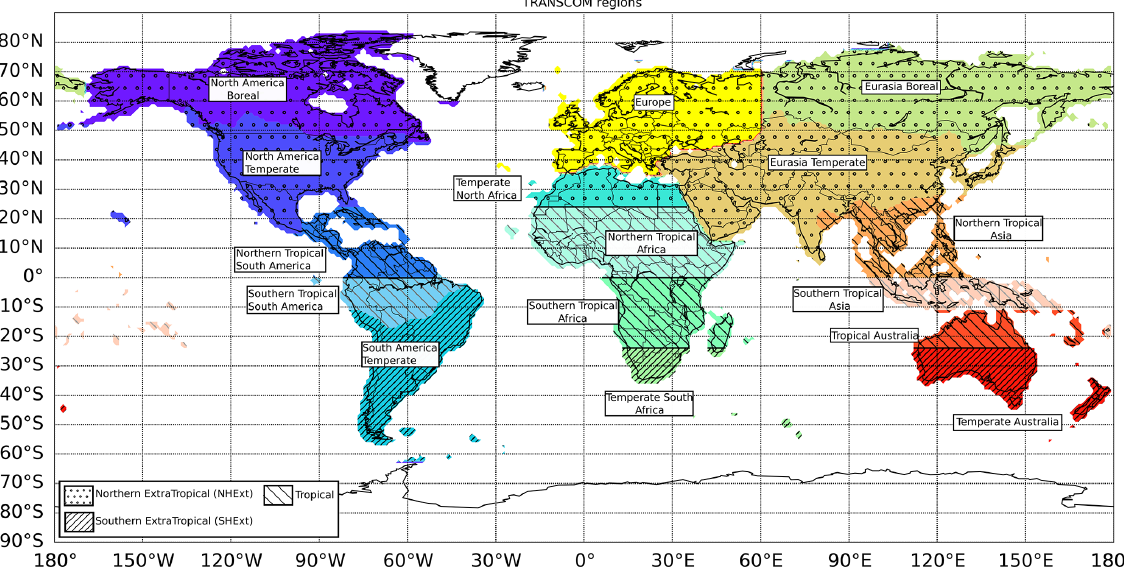
Figure 5. OCO-2 MIP regions to which gridded fluxes are aggregated for comparison and